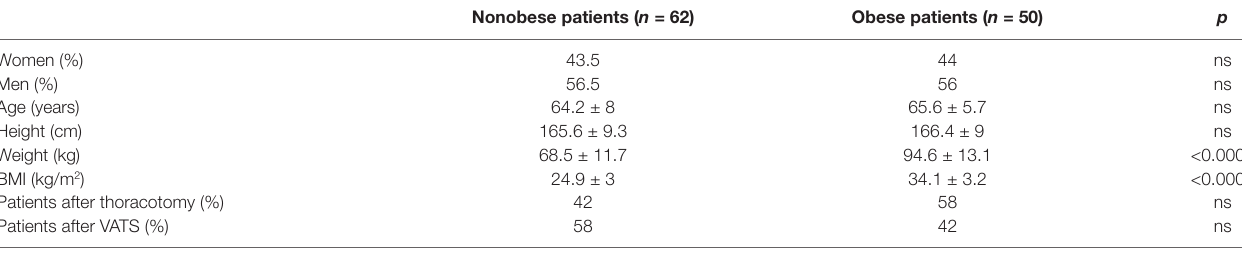
ns, not statistically significant; BMI, body mass index.